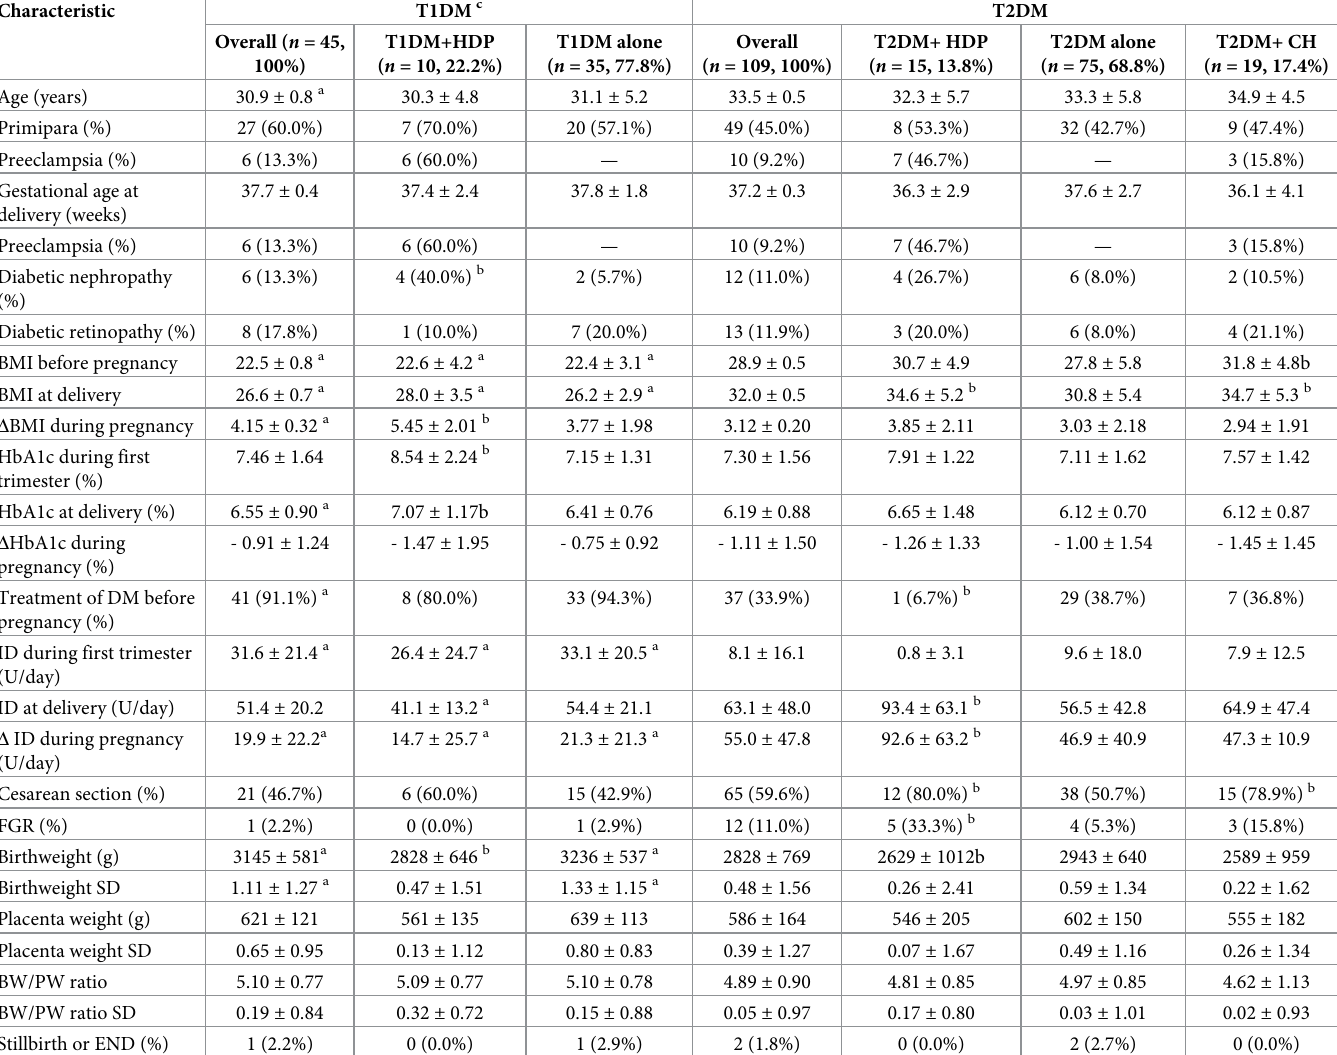
Table 1. Characteristics of pregnant women with and without hypertension with T1DM and T2DM during